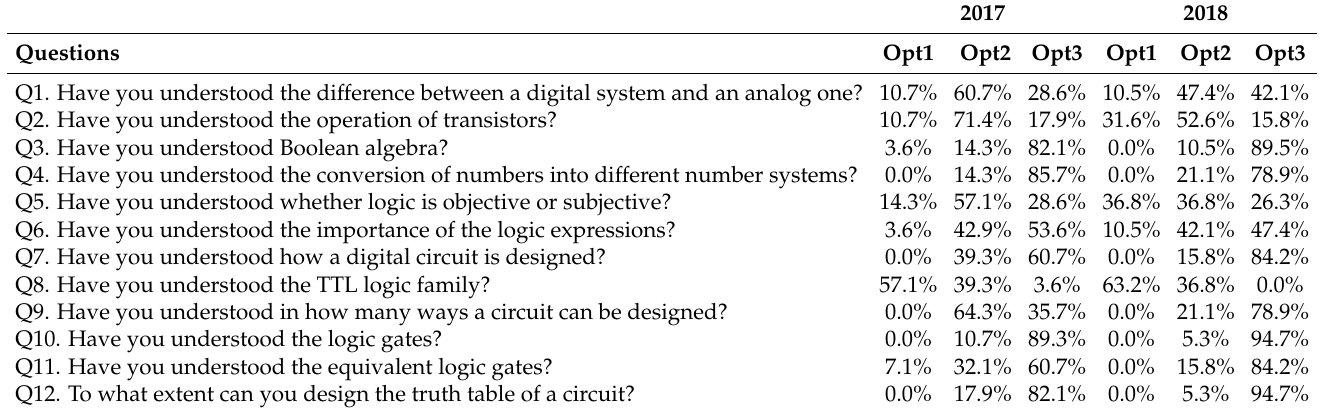
Table A1. Questionnaire 1.